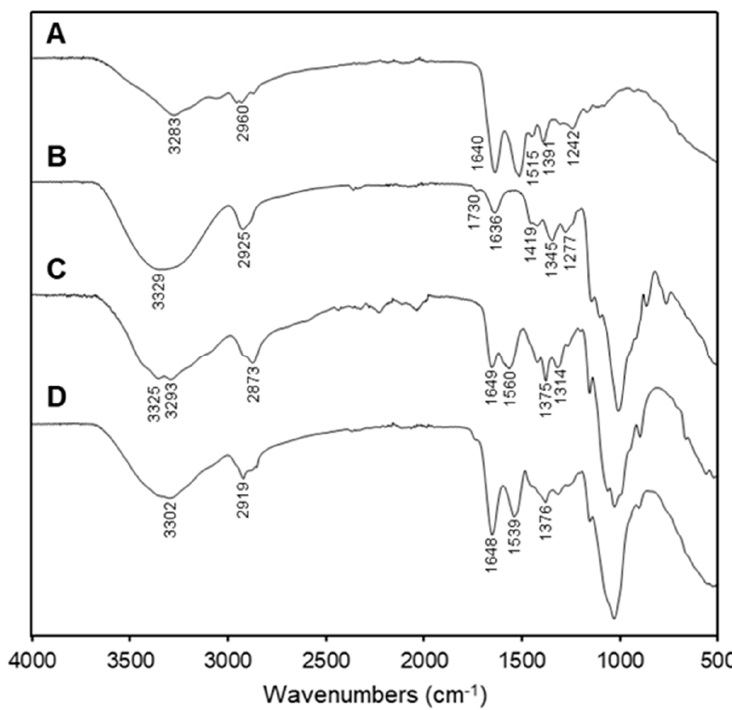
Figure 3. The FTIR spectra of ( A ) bovine serum albumin (BSA), ( B ) oxidized dextran (OD), ( C ) chitosan beads, and ( D ) 200B-90m bead.